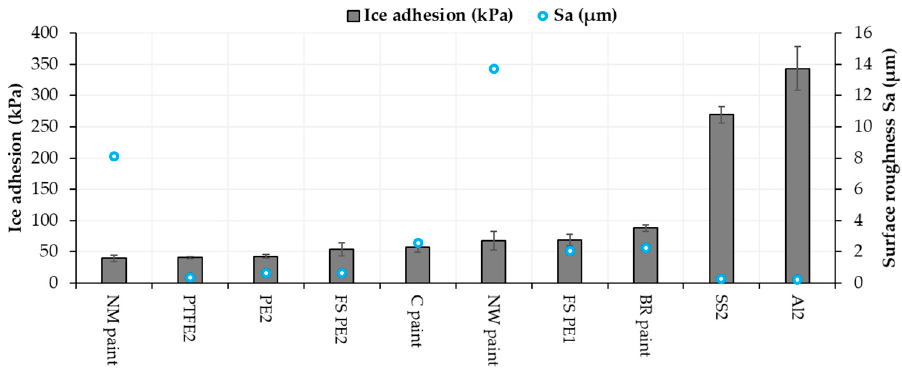
Figure 11. Ice adhesion and surface roughness (Sa) for selected materials and surfaces.